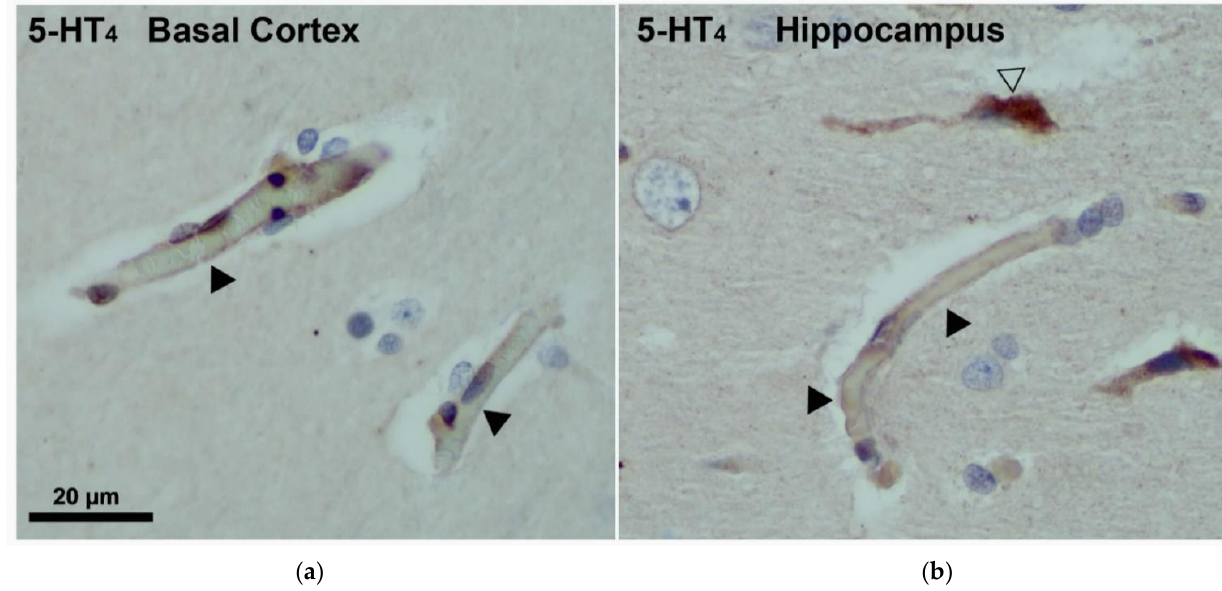
Figure 1. Photomicrograph illustration of 5-HT 4 receptor immunohistochemistry analysis in human brain ( a ) shows capillary vessels stained with 5-HT 4 receptor antibody in the basal cortex and ( b ) in hippocampus. A 5-HT 4 labeling is present on endothelial cells of capillary vessels ( ) and neurons ( ).